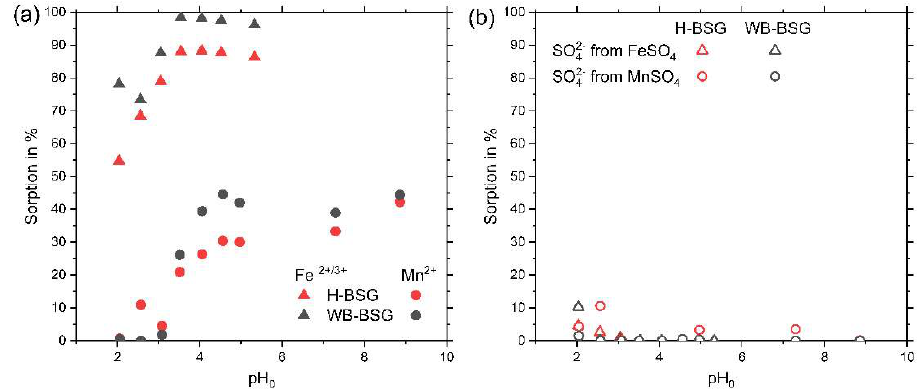
Figure 7. Influence of the initial pH on ions adsorbed onto BSG. ( a ) Metal ions Fe 2+/3+ and Mn 2+ , ( b ) corresponding sulfate ions. Batch experiments performed with solutions of FeSO 4 and MnSO 4 (0.5 mmol/L) and 3.33 g/L dosage of H-BSG or WB-BSG for 24 h at r.t. The initial pH was adjusted with H 2 SO 4(aq) and NaOH (aq) , respectively.